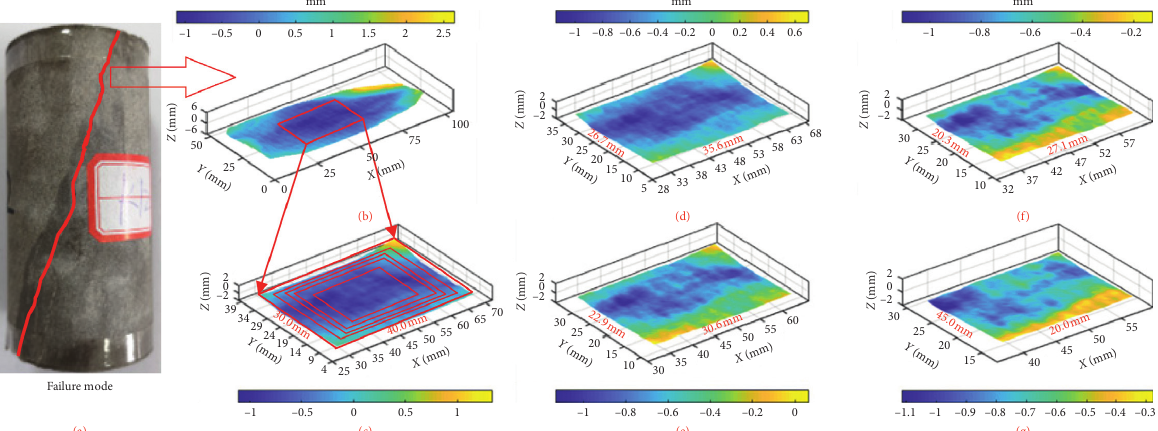
Figure 3: (a) Failure mode of sandstone specimen, (b) 3D image of fracture surface, (c) research area ( l � 40.0mm, w � 30.0 mm),